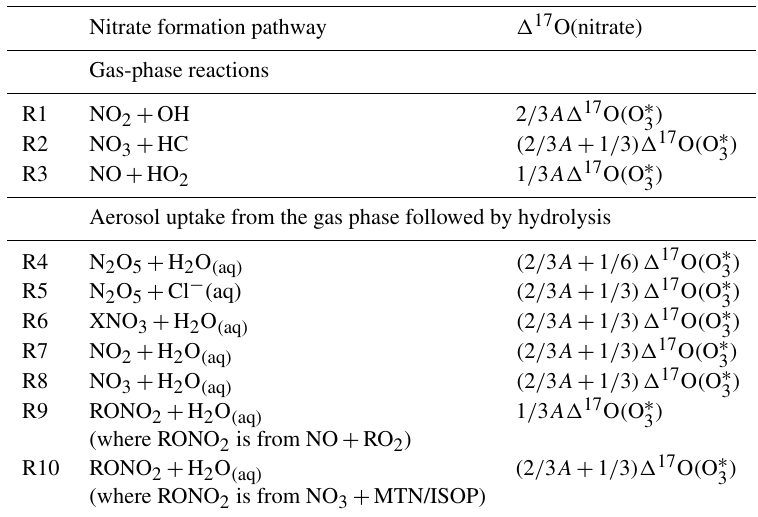
Table 1. Calculated (cid:49) 17 O(nitrate) in the model for each nitrate production pathway (X = Br, Cl, and I; HC: hydrocarbon; MTN: monoter- ) = 39‰). A is defined in Eq. penes; ISOP: isoprene; (cid:49) 17 O ( O ∗ 3